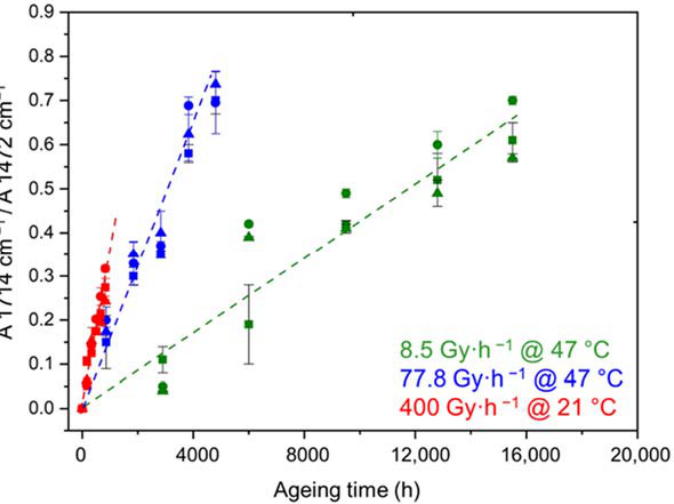
Figure 4. Changes in the carboxylic acid index of the Si ‐ XLPE matrix filled with 0 phr ( □ ), 25 phr ( ∆ ), and 50 phr ( ) of ATH, during its radio ‐ thermal exposure in air under 8.5 Gy ∙ h − 1 at 47 °C (green), under 77.8 Gy ∙ h − 1 at 47 °C (blue), and under 400 Gy ∙ h − 1 at 21 °C (red).